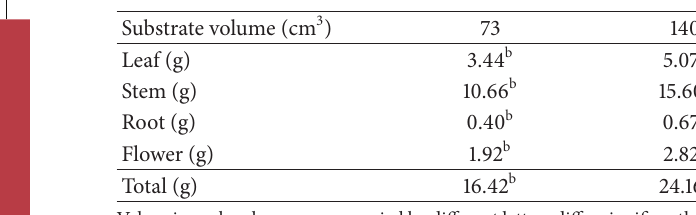
Table 7: Effect of substrate volumes on leaf dry weight, stem dry weight, root dry weight, flower dry weight, and total dry weight.